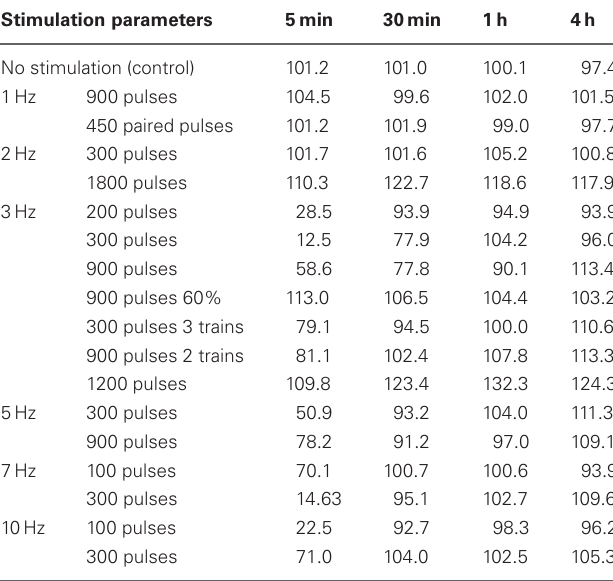
Table 1 | Summary of stimulation parameters and evoked responses 5min, 30min, 1h, and 4h post-stimulation.